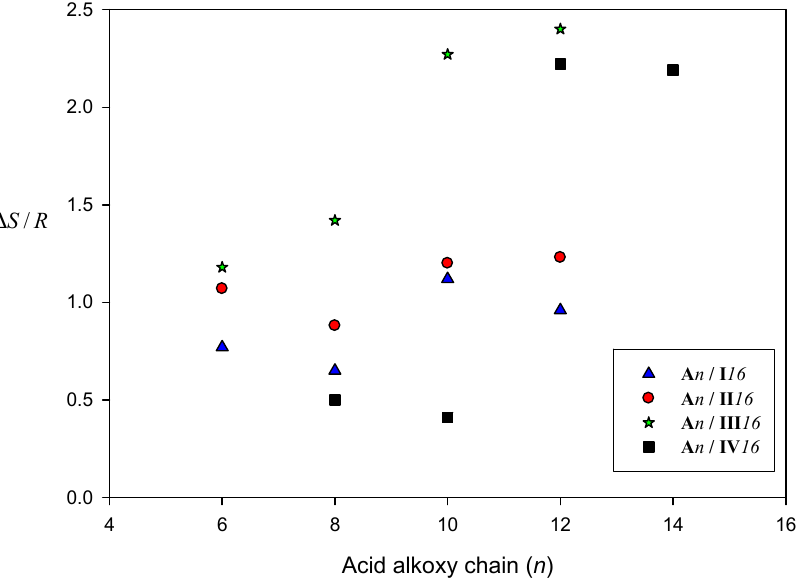
Figure 9. Comparison of the entropy changes of nematic transitions for SMHB complexes A n / I 16 ( ▲ ); A n / II 16 ( ● ); A n / III 16 ( * ); A n / IV 16 ( ).